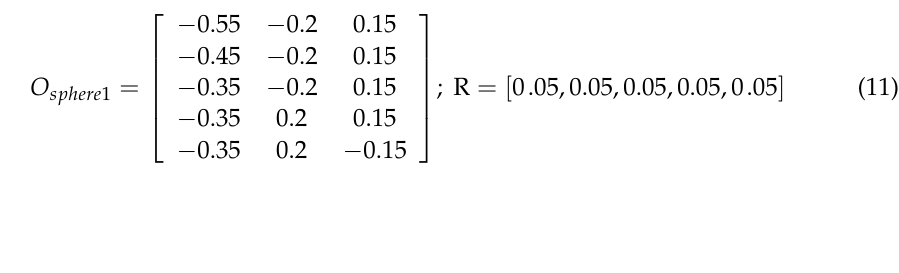
Figure 14. GA_RRT obstacle avoidance trajectory: ( a ) self-collision avoidance; ( b ) side view of final state.